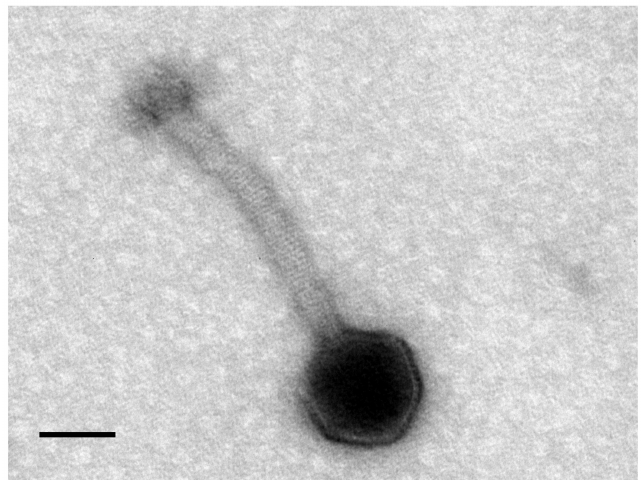
Figure 1. Morphology of LM12. Transmission electron microscopic image of Staphylococcus myovirus LM12 negatively stained with 2% ( w / v ) uranyl acetate. Scale bar represents 50